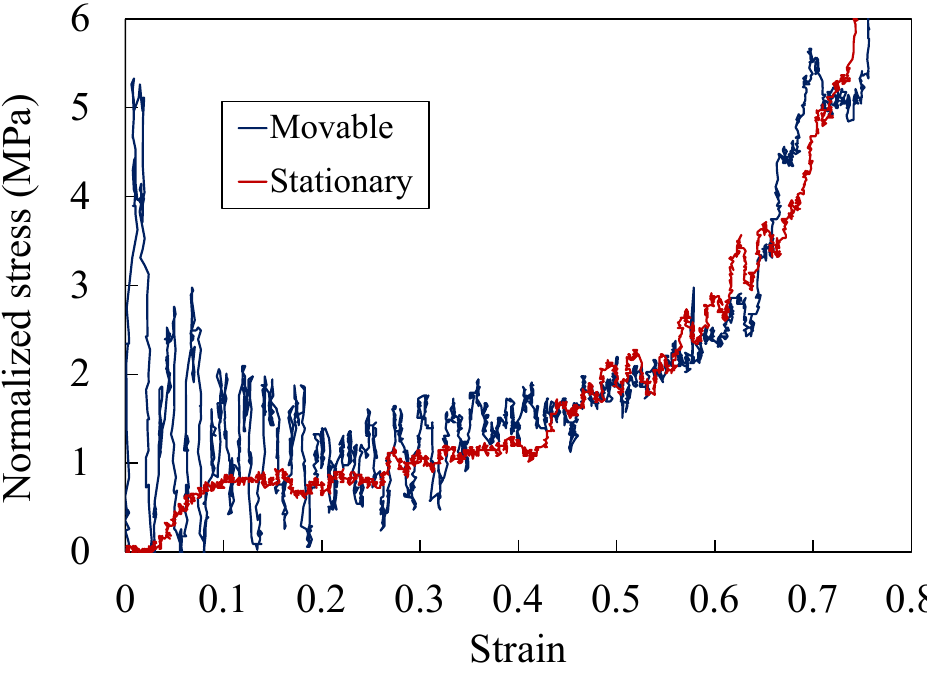
Figure 13. Typical normalized stress–strain relationship of Ni foam in an impact test conducted at compression rate of approximately 26.0 m/s.